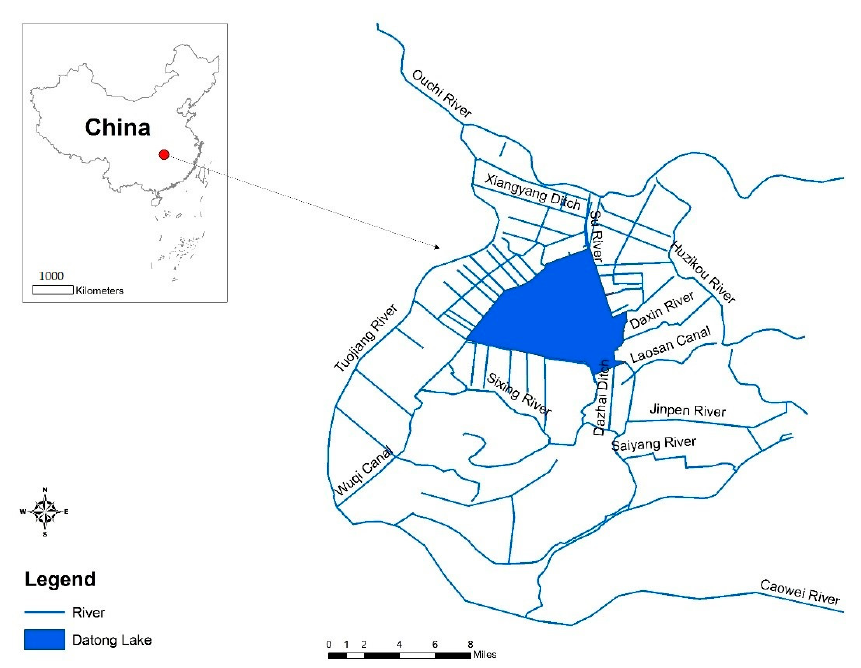
Figure 1. Location of the study area.